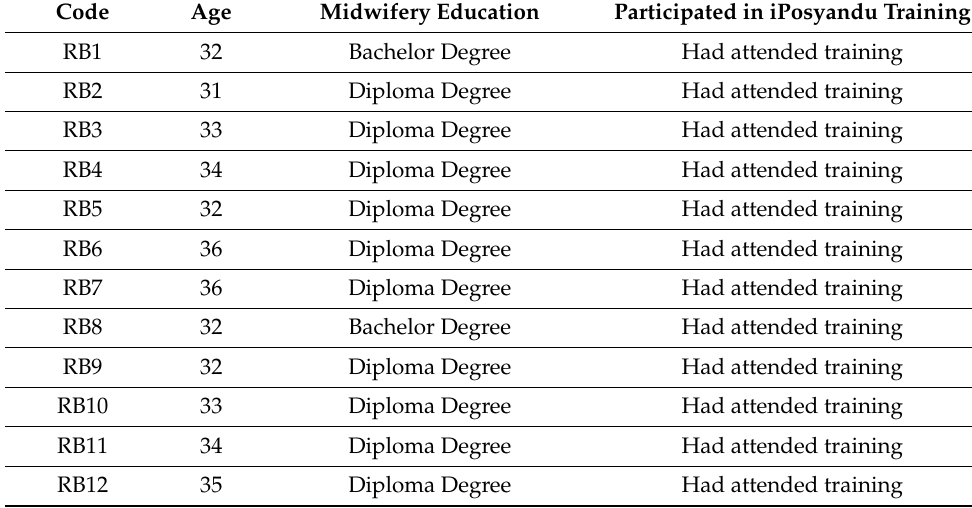
Table 2. Characteristics of Midwife